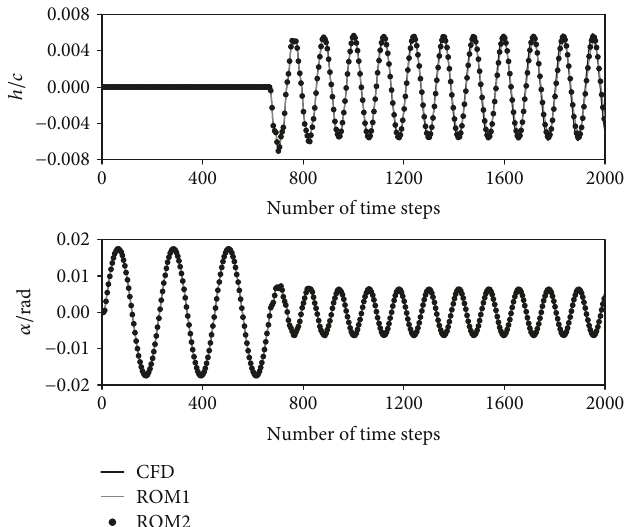
M α = 0 deg (ROM1-training data via CFD; ROM2-training ∞ = 0 81 and ∞ = 0 73 at 0